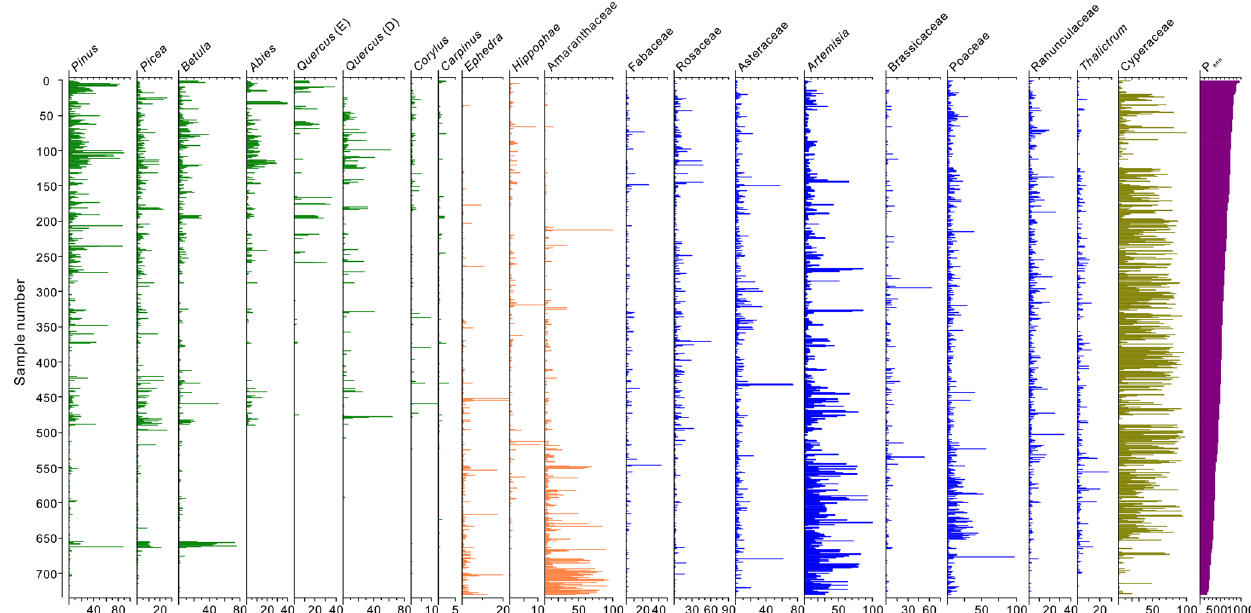
Figure 2. Pollen assemblages of surface sediment samples with annual precipitation ( P ann ) from the eastern Tibetan Plateau.